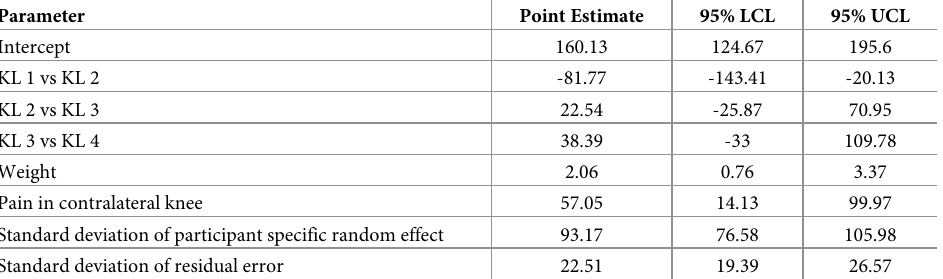
Table 3. Parameter estimates in multiple regression model for AE number of hits. Point estimates and 95% confi- dence intervals for parameter estimates in the multiple regression model for the ‘Number of hits’. (LCL: lower confi- dence limit; UCL: upper confidence limit). The intercept is the average number of hits across all KL scores in individuals of mean weight and no pain in the contralateral